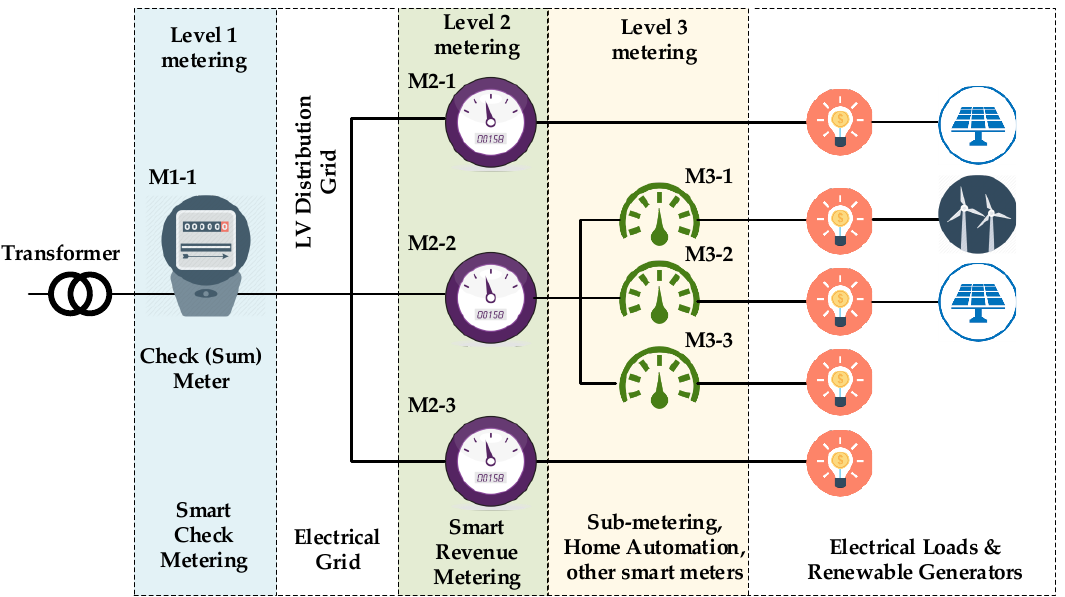
Figure 1. Classification of power meters’ installation levels in the smart electrical grid.